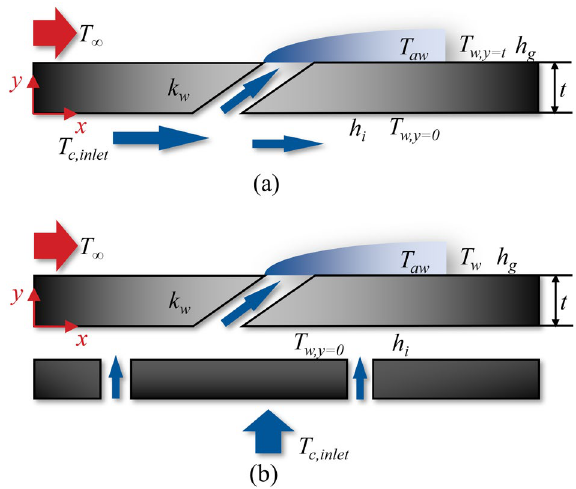
Figure 1. Schematic diagrams of cooling plate. ( a ) Film hole cooling plate; ( b ) Impingement effusion cooling